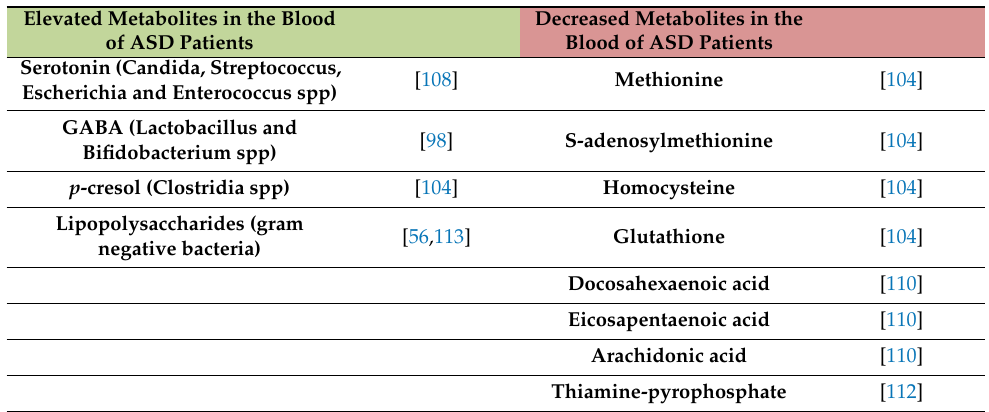
Table 2. Summary of statistically significantly elevated and decreased metabolites in the blood of autistic patients. Major bacteria responsible for the elevated metabolites are given in